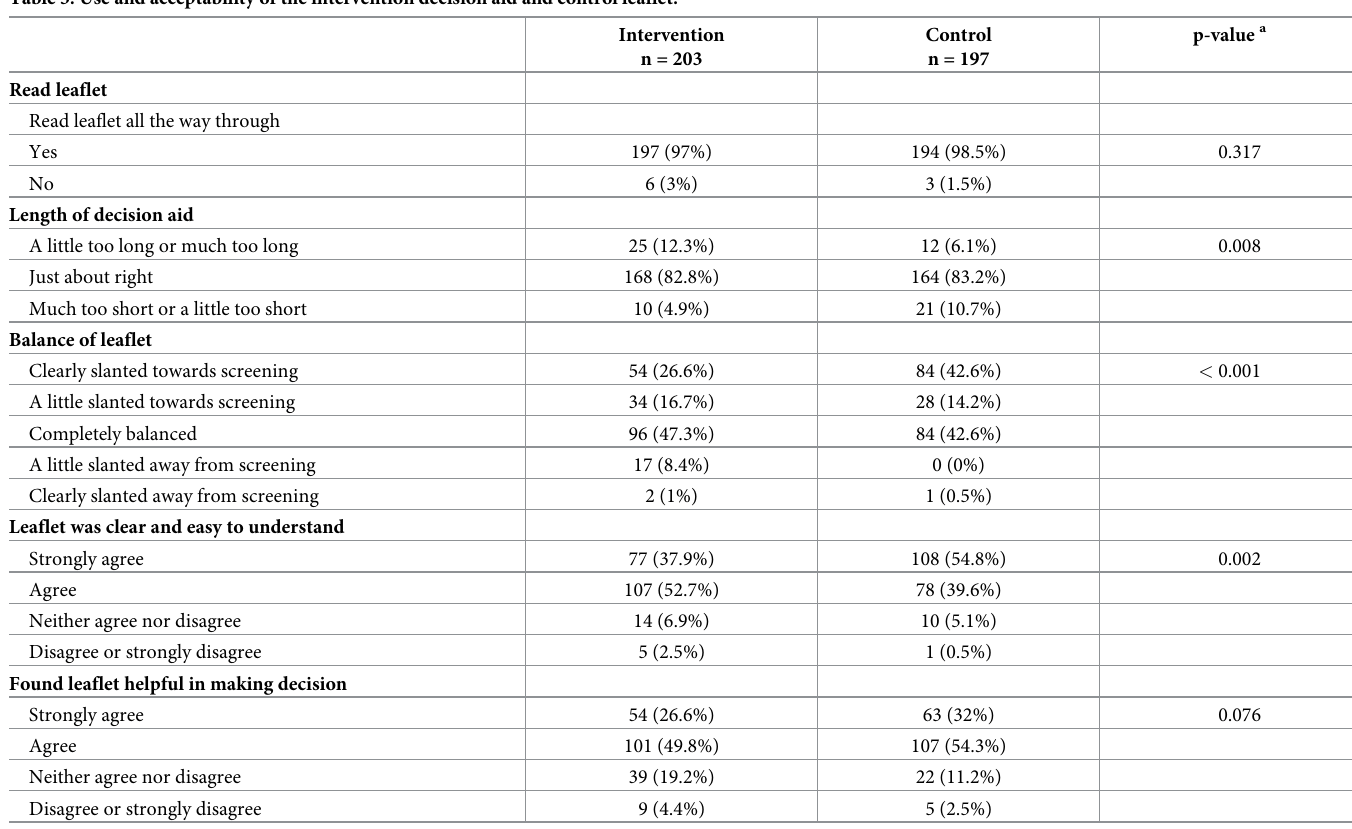
Table 5. Use and acceptability of the intervention decision aid and control